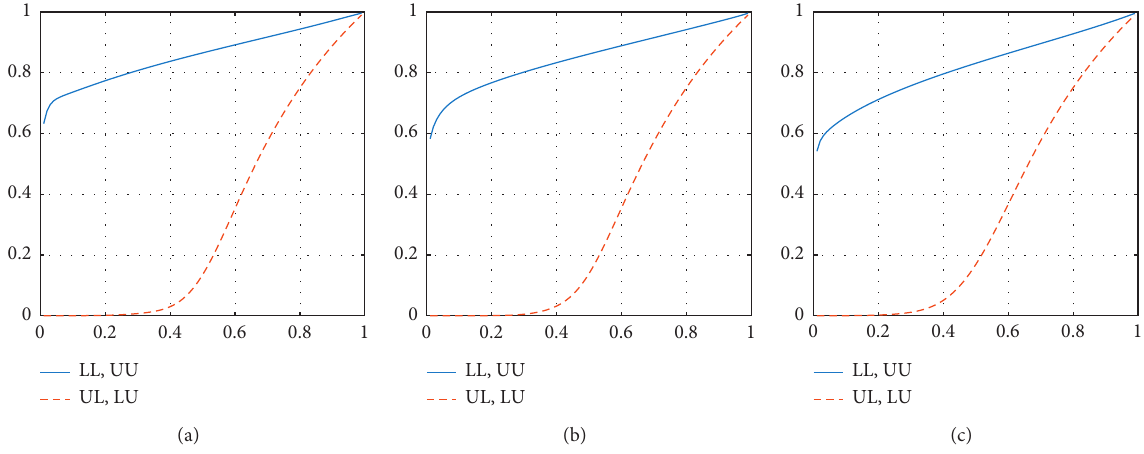
Figure 14: QD curves of bivariate CCC-CN copula model. (a) HSI-CEI. (b) HSI-CCI. (c) CEI-CCI.